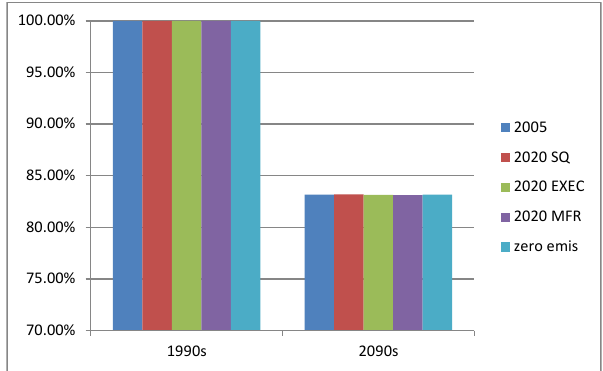
Figure 8. The relative changes of the total mercury deposition to the Arctic areas north of Polar Circle for all emissions scenarios between the 1990s and the